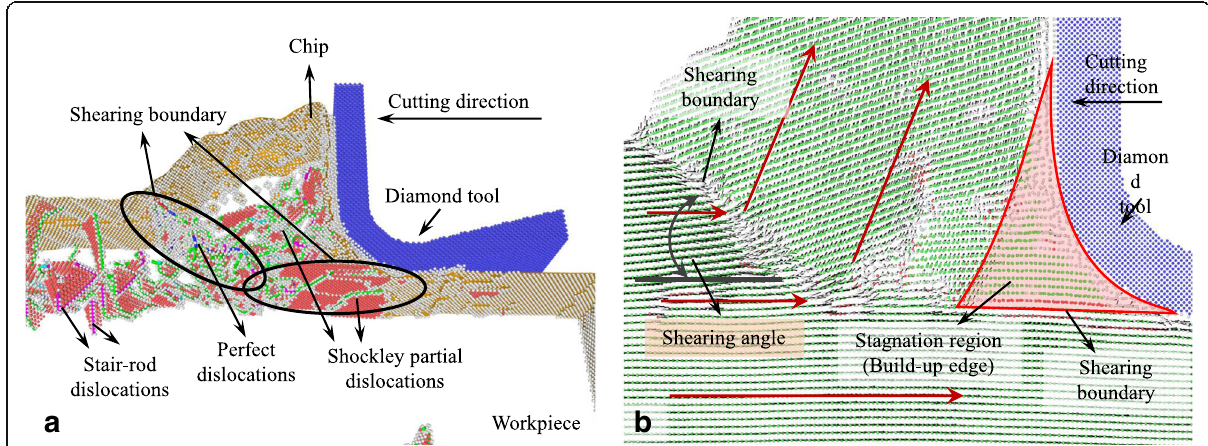
Fig. 7 a Snapshots of the microstructure evolution at cutting direction of {111}<1-10>, b displacement vector sliced at 4 nm in z direction